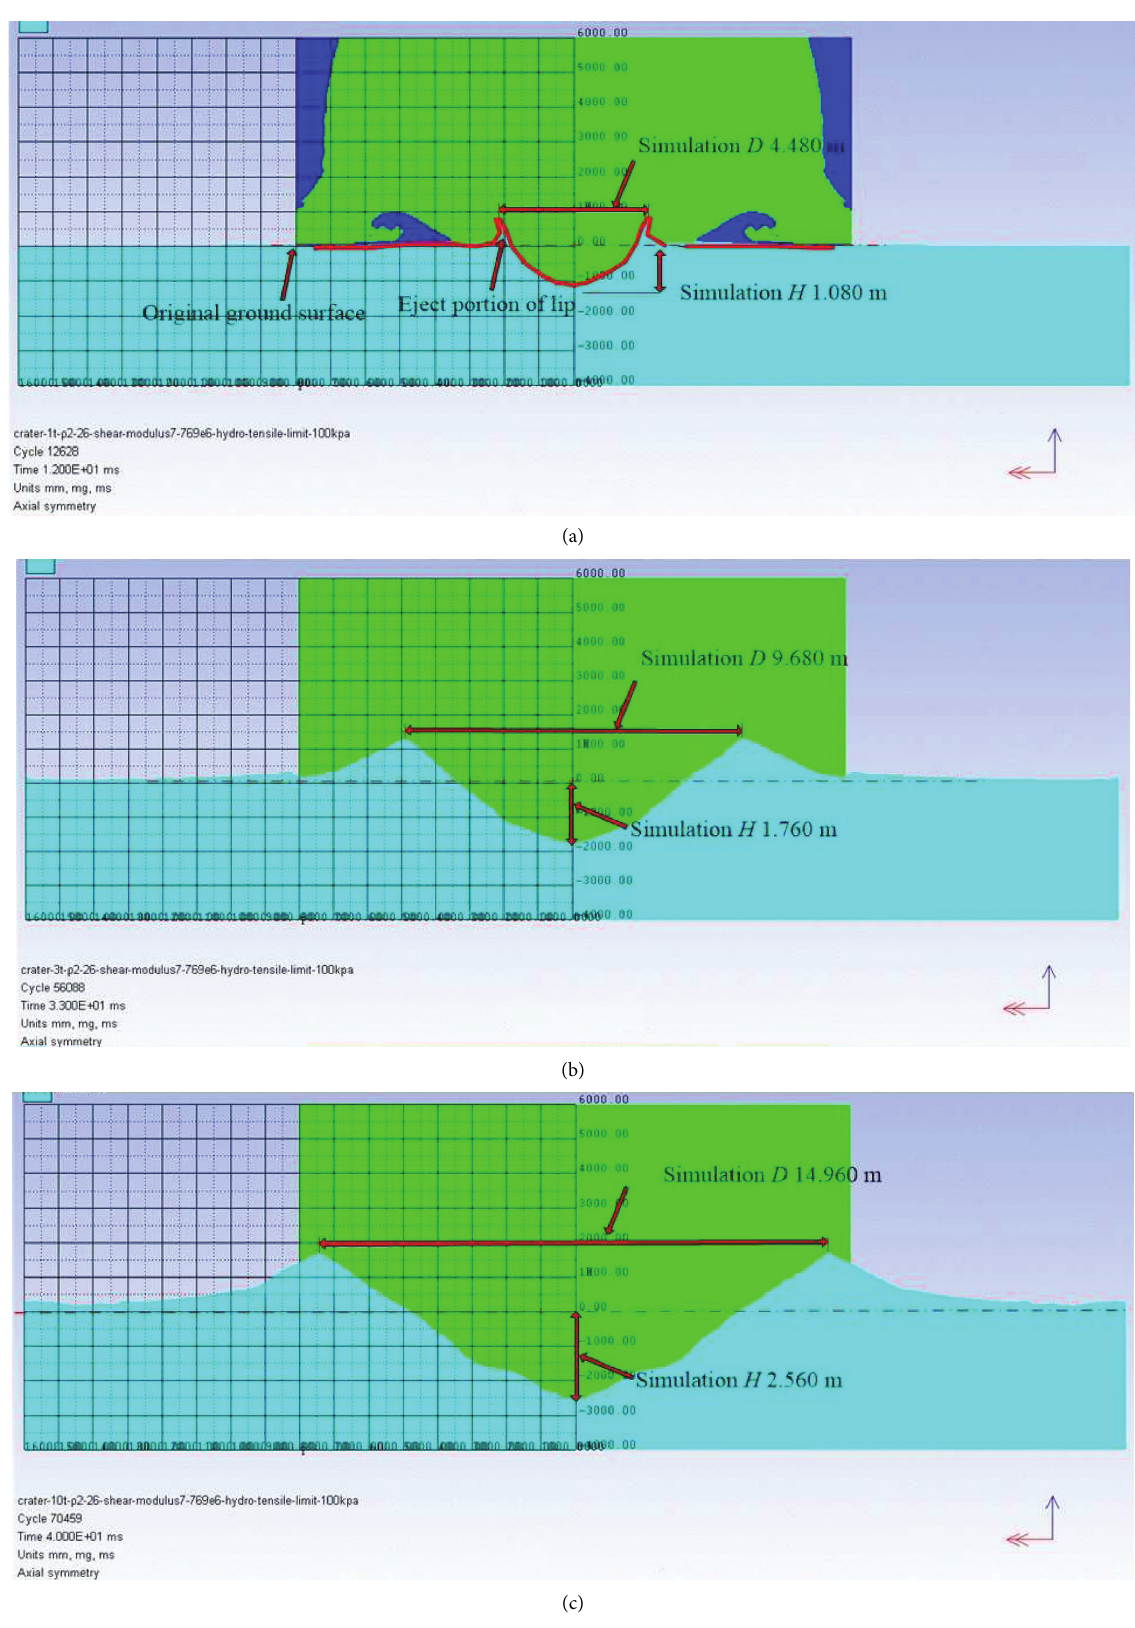
Figure 7: Profiles of the crater generated by (a) 1 ton, (b) 3 tons, and (c) 10 tons of